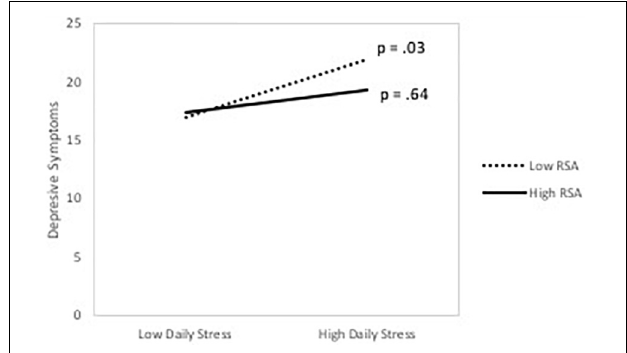
FIGURE 3 | The association between daily stress and depressive symptoms as a function of respiratory sinus arrhythmia (RSA) among women. p -values represent the significance of the simple slopes at high (1 SD above the mean) and low (1 SD below the mean) of RSA.